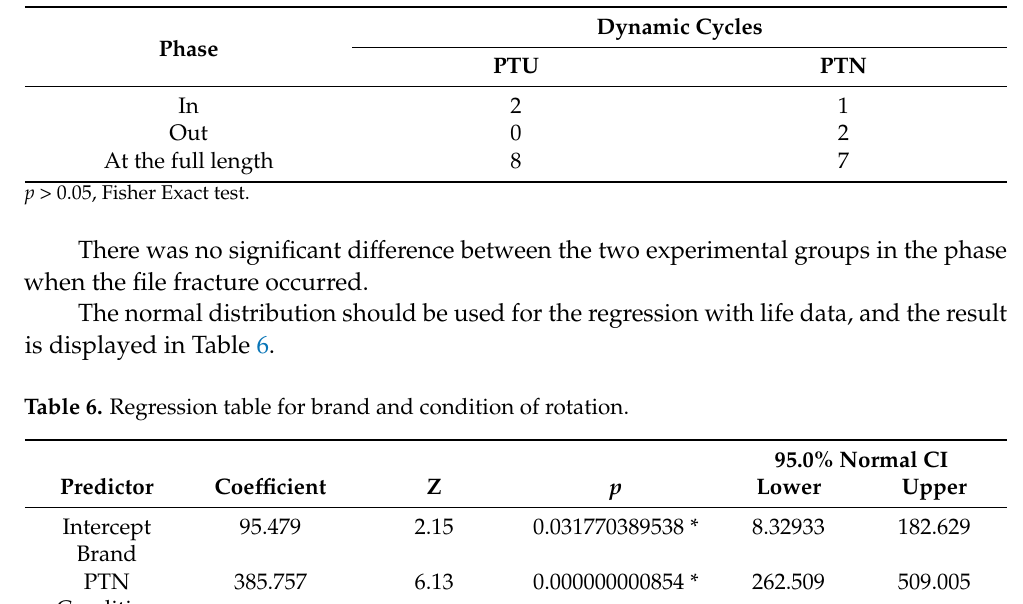
Table 5. Phases when the file fracture happened.